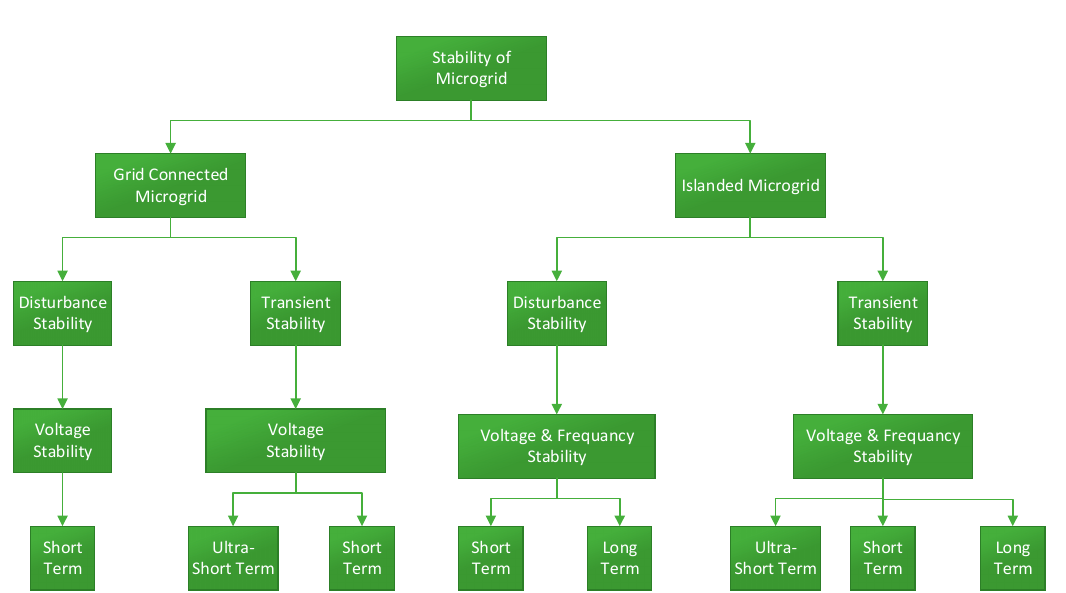
Figure 8. Microgrid stability classification.